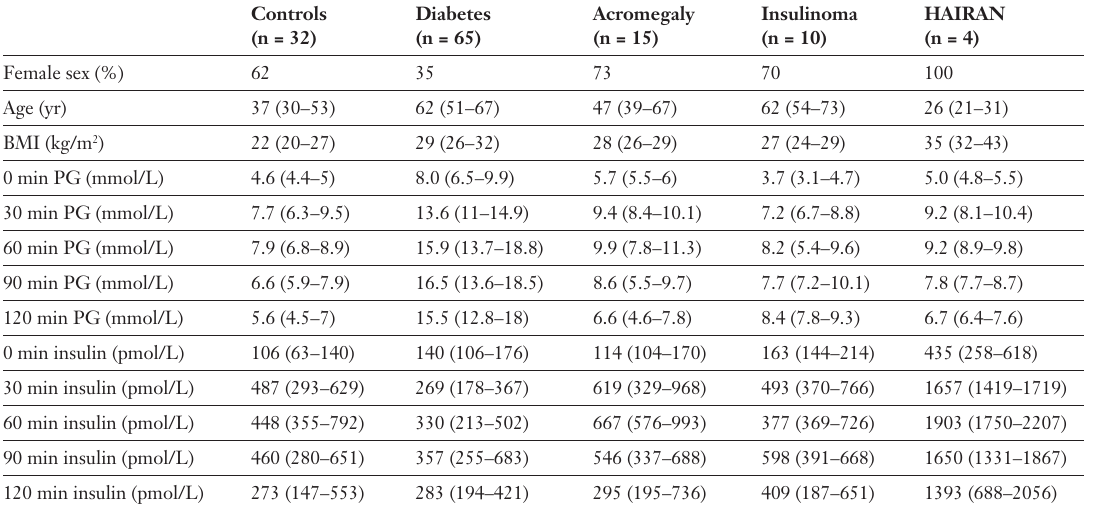
Figure 1 Whole-body insulin sensitivity index and insulinogenic index. Whole-body insulin sensitivity index and insulinogenic index derived from the OGTT in 32 healthy controls, 65 type 2 diabetic patients, 15 patients with acromegaly, 10 in- sulinoma patients, and 4 patients with HAIRAN syndrome. Data are shown as median and quartiles (Q 25 –Q 75 ), the indexes are compared with healthy controls. (* p <0.05, ** p <0.005).